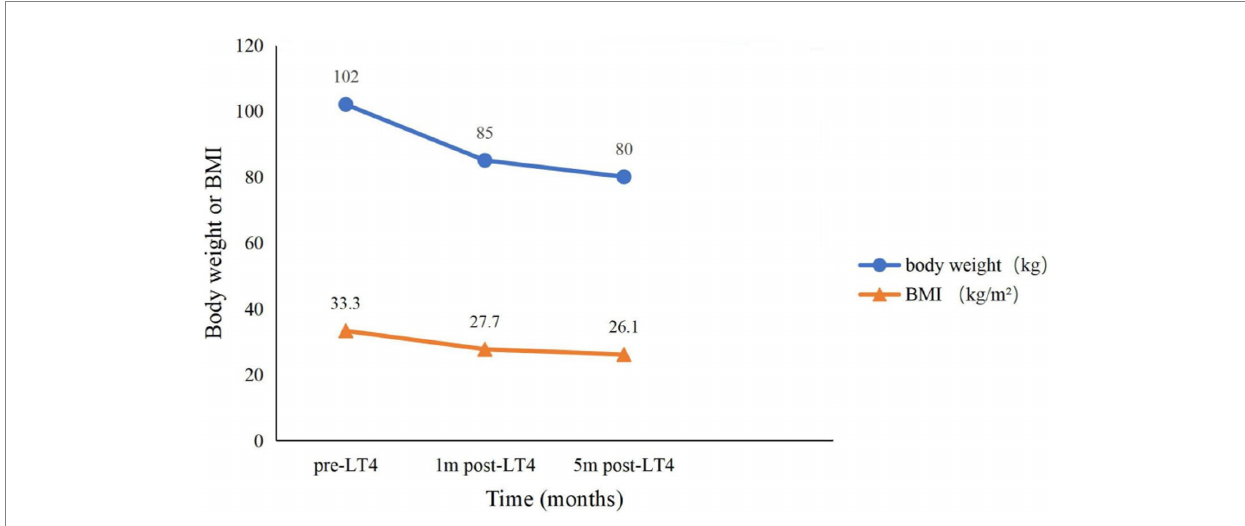
FIGURE 1 Trends in body weight and BMI over time. Pre-LT4, before levothyroxine treatment; 1 m post-LT4, 1 month after levothyroxine treatment; 5 m post-LT4, 5 months after levothyroxine treatment; BMI, body mass